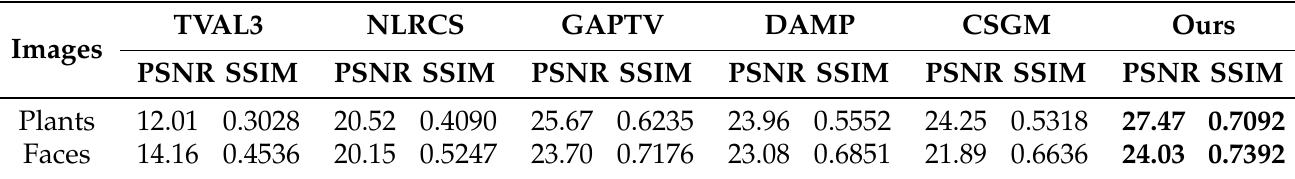
Table 3. Average PSNR and SSIM comparisons using images with Gaussian noise. Bold indicates the best result.